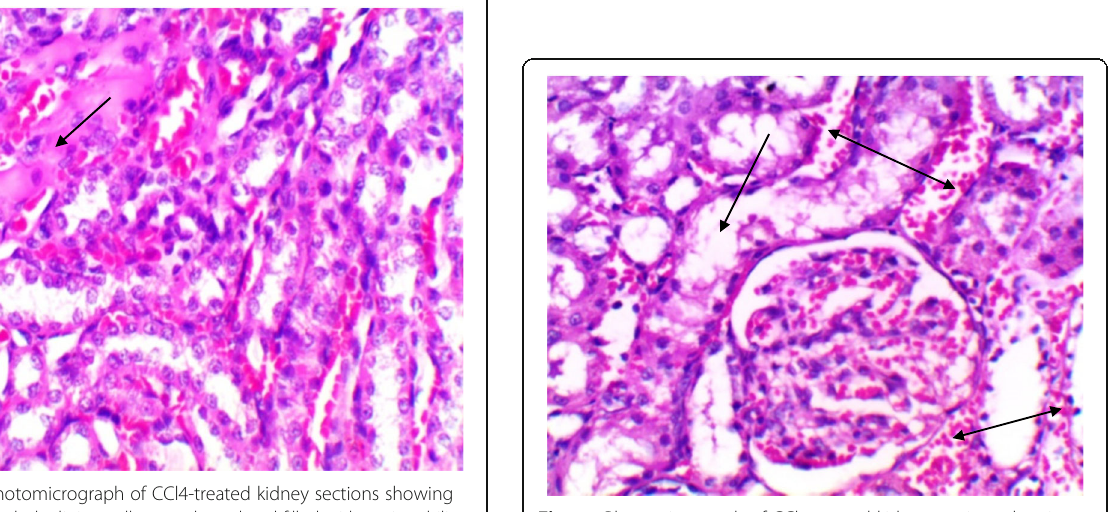
Fig. 15 Photomicrograph of CCl4-treated kidney sections showing